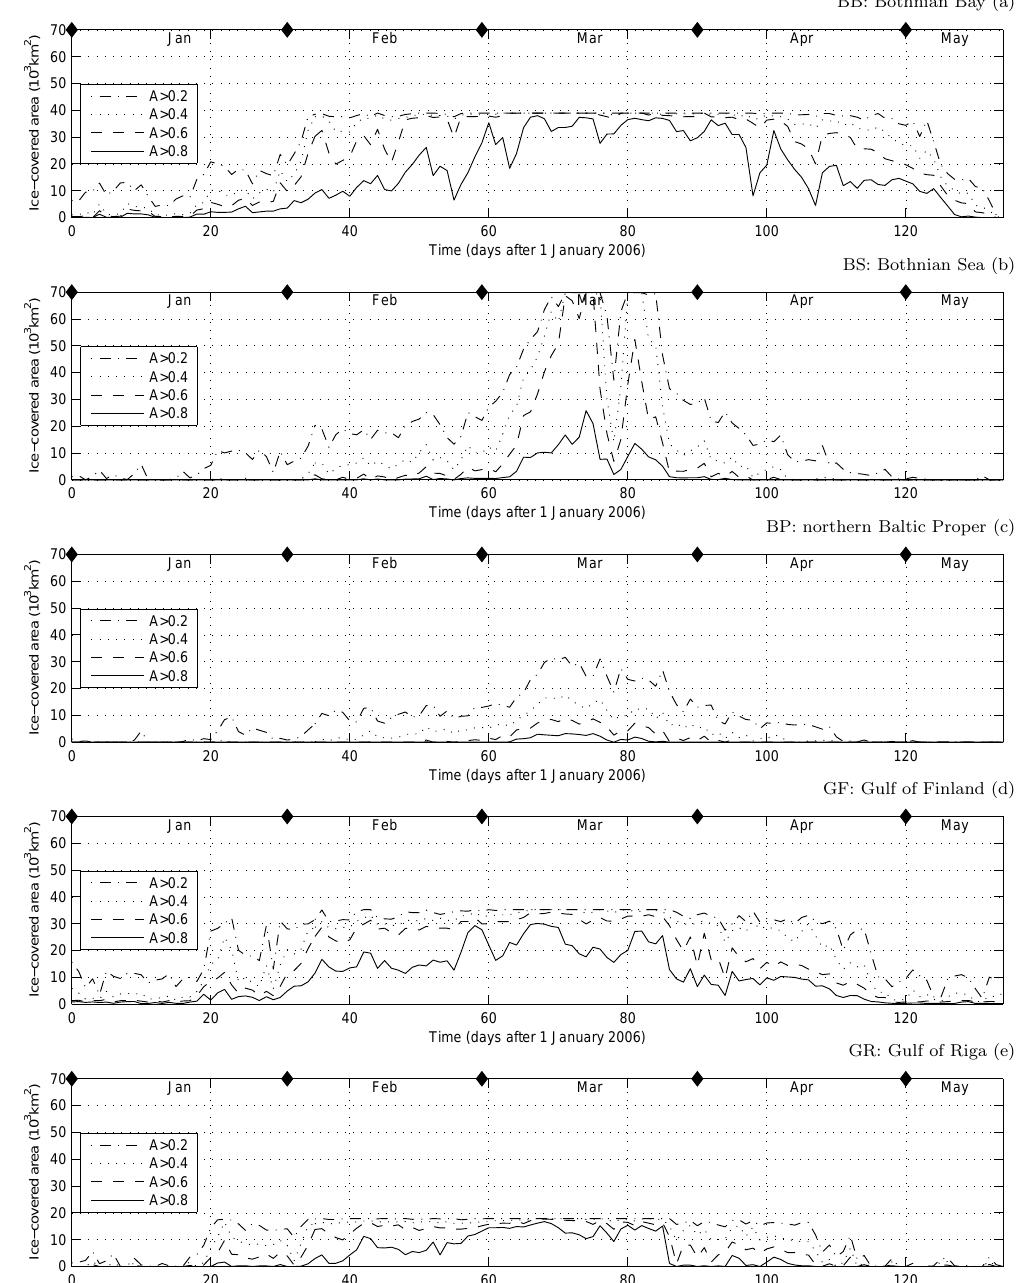
Fig. 3. Time series of the area (in 10 2 km 2 ) covered with ice concentrations higher than 0.2 (continuous lines), 0.4 (dashed lines), 0.6 (dotted lines) and 0.8 (dash-dotted lines) for the five analyzed subbasins of the Baltic Sea (a–e) , marked in Fig. 1. Values calculated from the satellite-derived (NSIDC) daily ice concentration fields interpolated onto the model grid. areas (with A i > 0 . 2) in the Bothnian Bay were approximately equal, but the area with high ice concentrations ( A i > 0 .